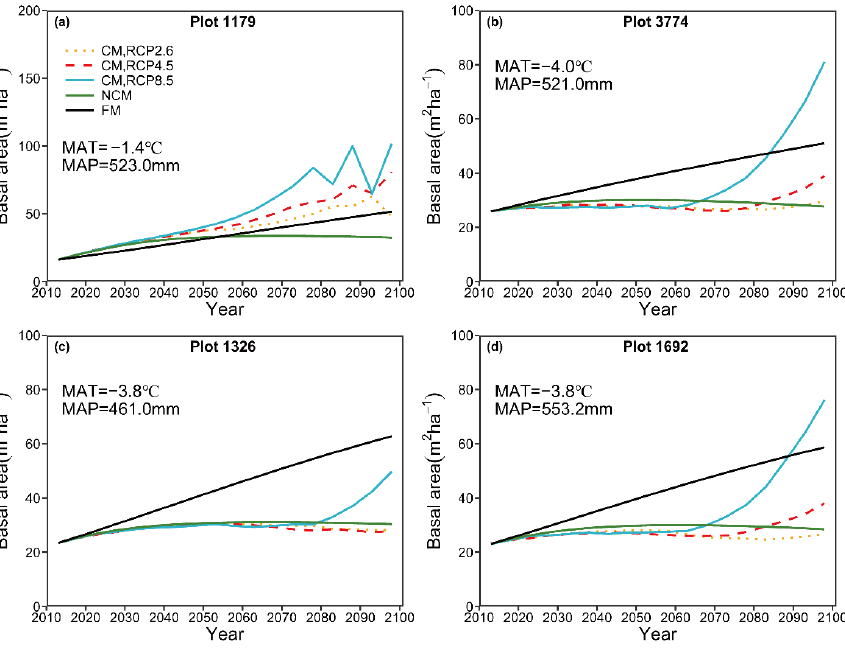
Figure 7. Long-term prediction of the basal area by the climate-sensitive model (CM) under three RCPs, the variable transition model which did not expect climate change (NCM), and the fixed- parameter model (FM), using NFI plots 1179, 3774, 1326, and 1692. The value of the MAT is the mean annual temperature between 2013 and 2018 and MAP represents the mean annual precipitation of the same period.